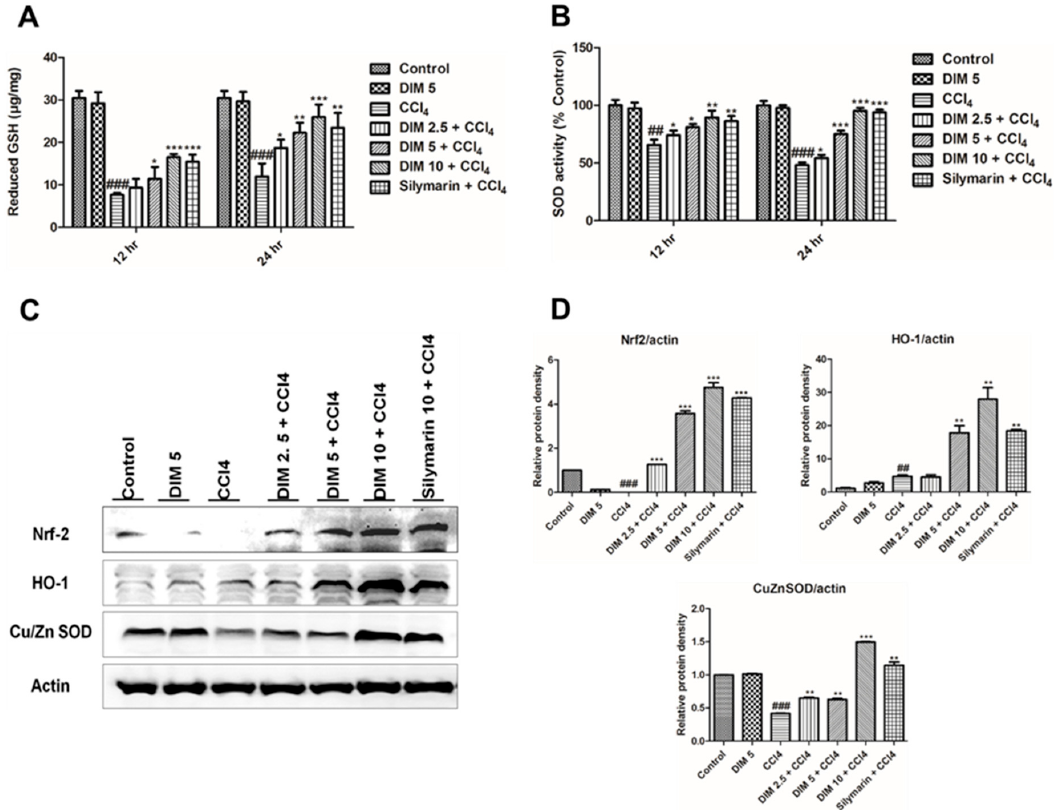
Figure 4. DIM increased detoxification and improved antioxidant ability by regulating the Nrf2/HO-1 signaling pathway and inhibiting oxidative stress in CCl 4 -induced liver injury in mice. ( A ) Reduced glutathione (GSH); ( B ) superoxide dismutase (SOD) activity; data are expressed as mean ± SD ( n = 5). ( C ) Protein expression of Nrf2, HO-1, and Cu/Zn SOD at 24 h after CCl 4 injection by using Western blot analysis. ( D ) Quantification of relative protein expression normalized to β -actin. Data are expressed as mean ± SD ( n = 3). ### p < 0.001 and ## p < 0.01 denotes significant differences compared to the normal control group, * p < 0.05, ** p < 0.01, *** p < 0.001 compared to the CCl 4 group.